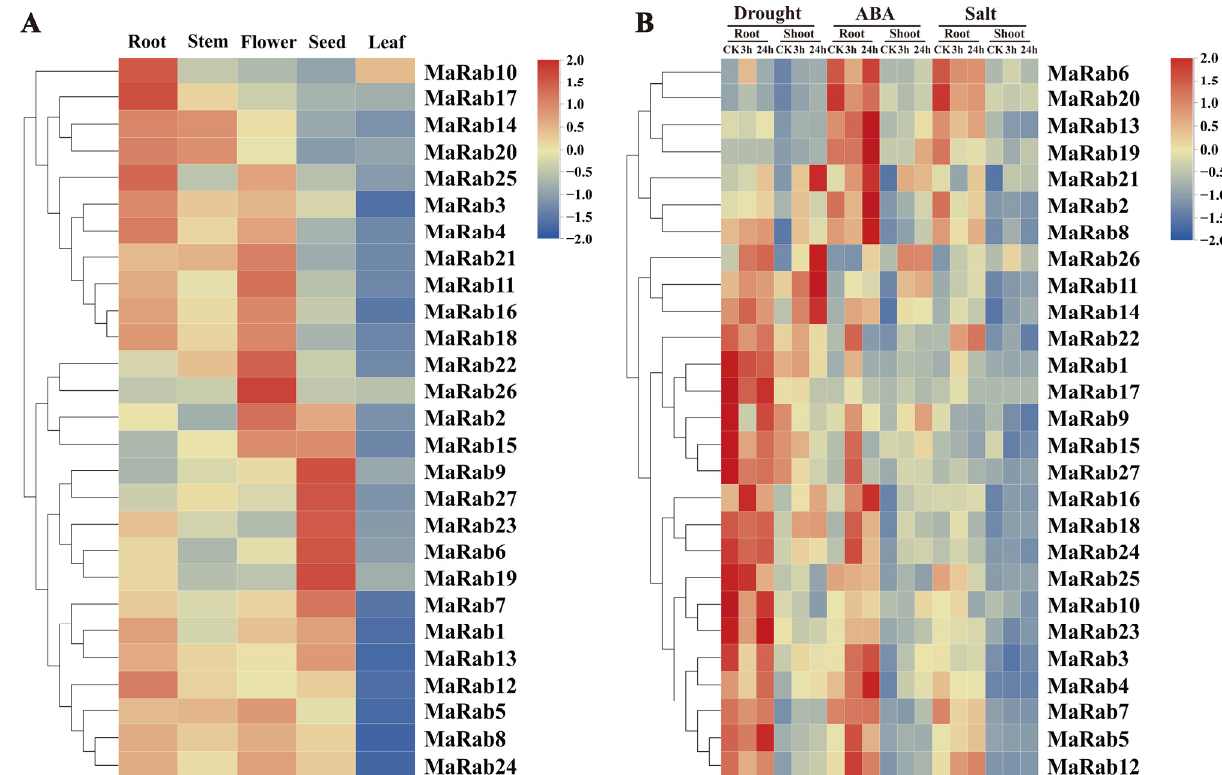
Figure 7. Expression pattern of MaRab genes: ( A ) patterns of MaRab gene expression in root, leaf, flower, stem and seed. Data were extracted from transcriptome datasets and clustered using TBtools. ( B ) Response of 27 MaRab genes to salt, drought and ABA treatments. Data were extracted from transcriptome datasets and clustered using TBtools. The heatmap depicts the relative levels of MaRab transcripts during salt, drought and ABA stress. Normalized expression values (FPKM) were obtained.